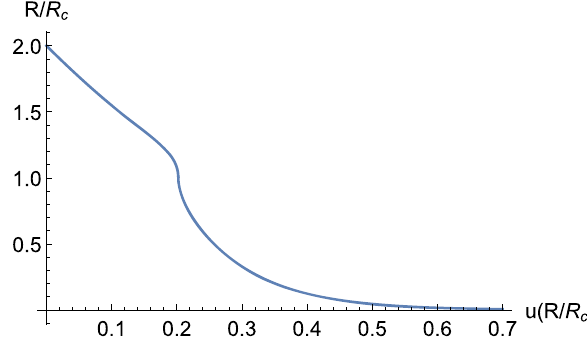
Fig. 3 The affine parameter for timelike ( k = − 1) radial ( L = 0) geodesics as a function of R / R c (note the inversion of axis), obtained by integration of the geodesic Eq. (49) with the effective potential (50), taking E = 6, m / R c = 10 and u c = 2. Note that in this figure the wormhole throat is located at R = R c = 1. As is apparent from this fig- ure, u can be indefinitely extended across the wormhole throat towards u → +∞ at R =